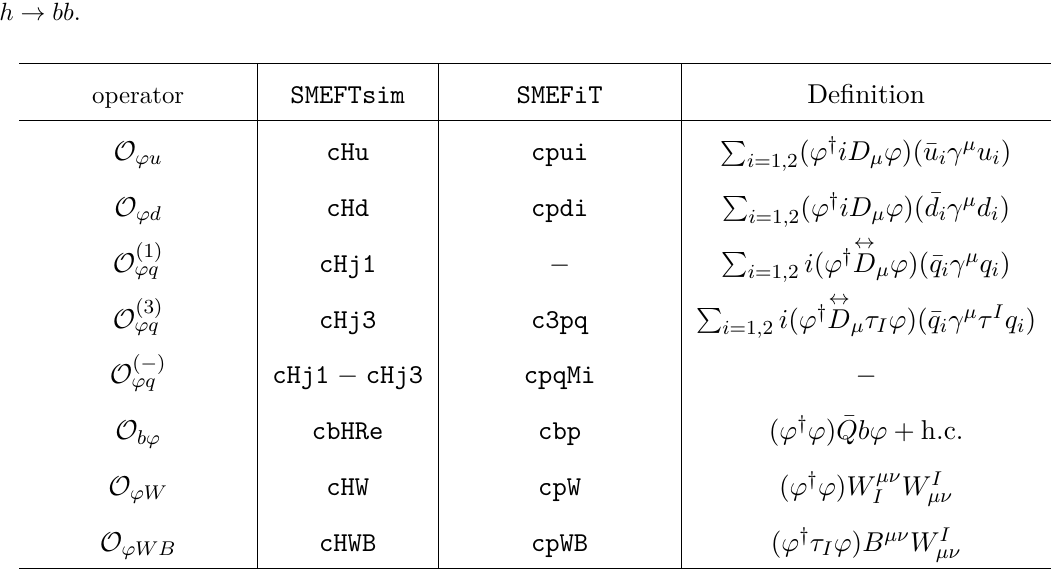
Table 4. Same as table 2 for Higgs associated production in the hZ → b ¯ b‘ + ‘ − final state. Only the operators selected by the Fisher information analysis of figure 5 are